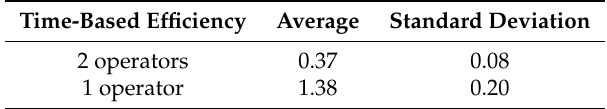
Figure 16. Interaction with the single-operator user interface performing a cooperative mission on the underwater training scenario: the external point of view is provided by an auxiliary robot. Sequence shown: ( 1 ) approaching the target, ( 2 ) grasping, and ( 3 ) recovering. Table 2. Time-based efficiency of the transport task in the simulated